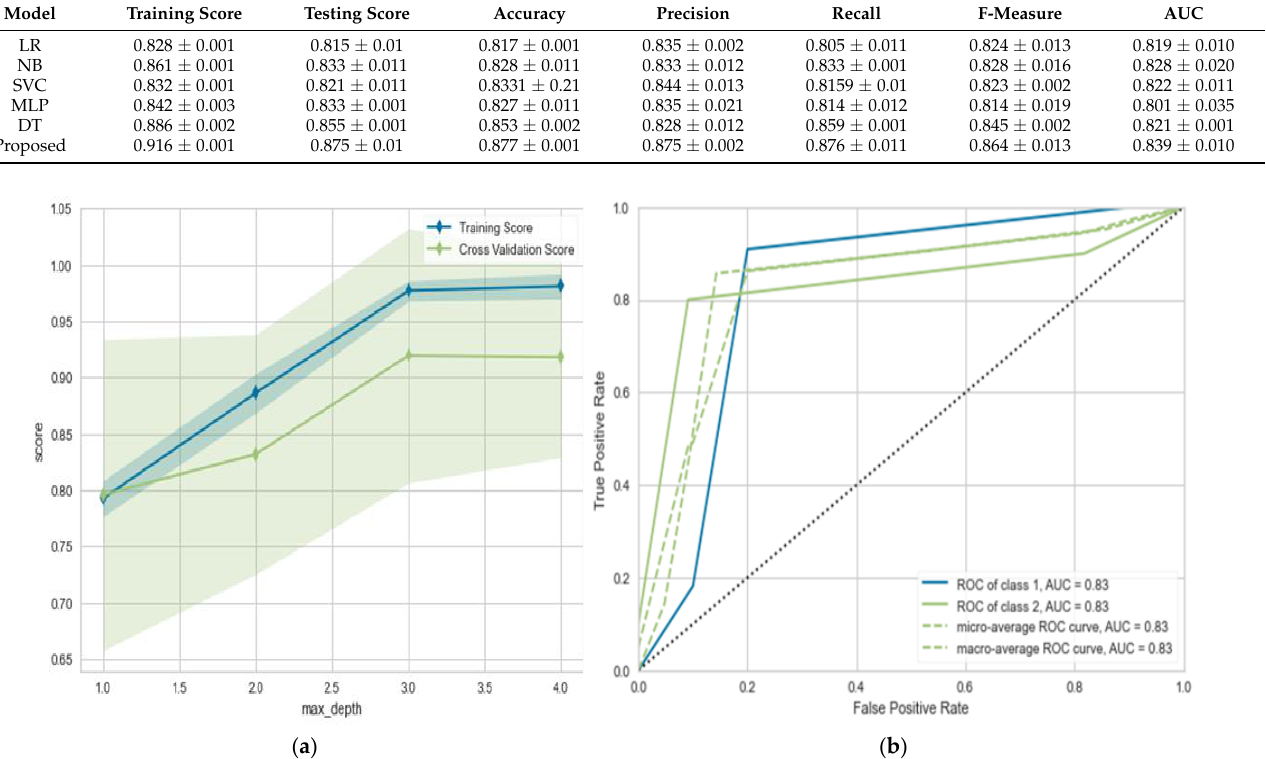
Table 3. Results of the prognosis model after 3 months.